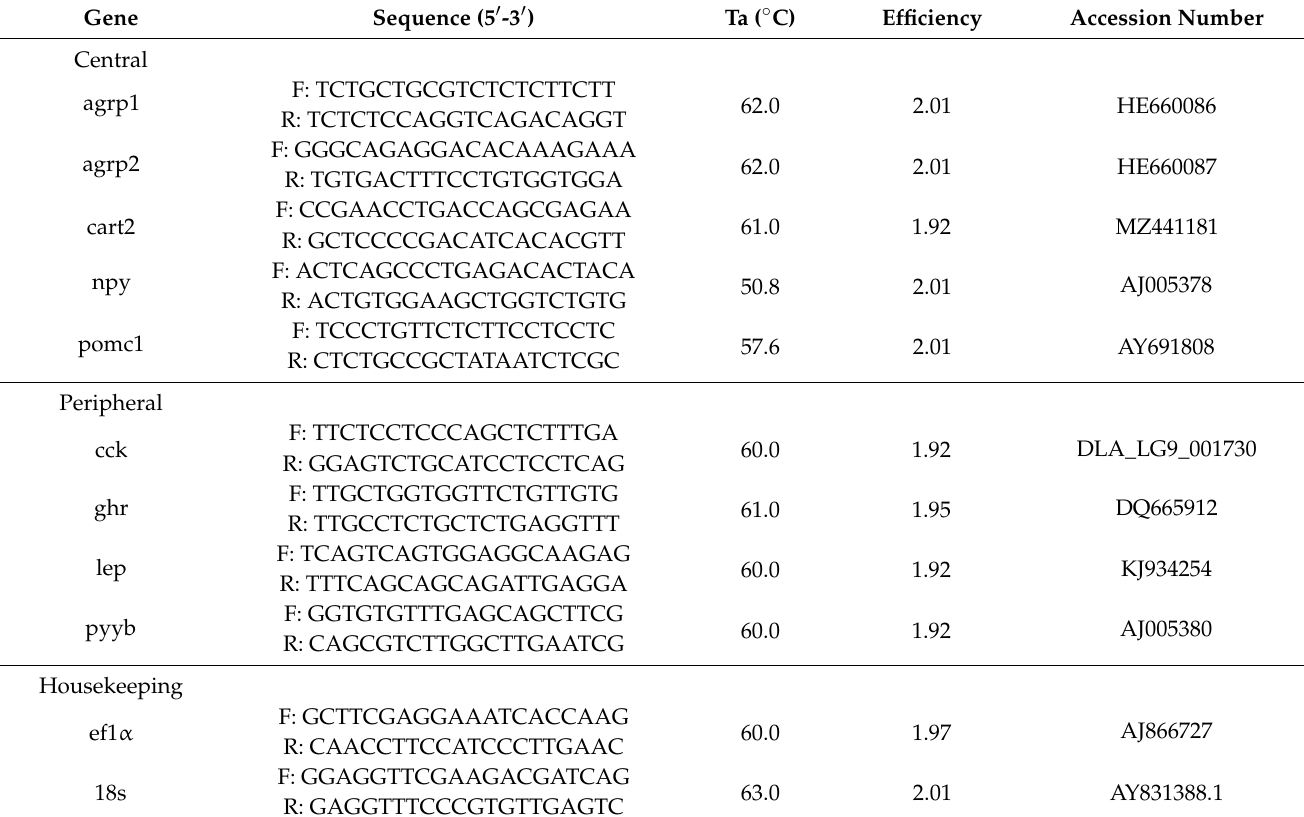
Table 1. Sequences of primers used for real-time quantitative PCR determination of several